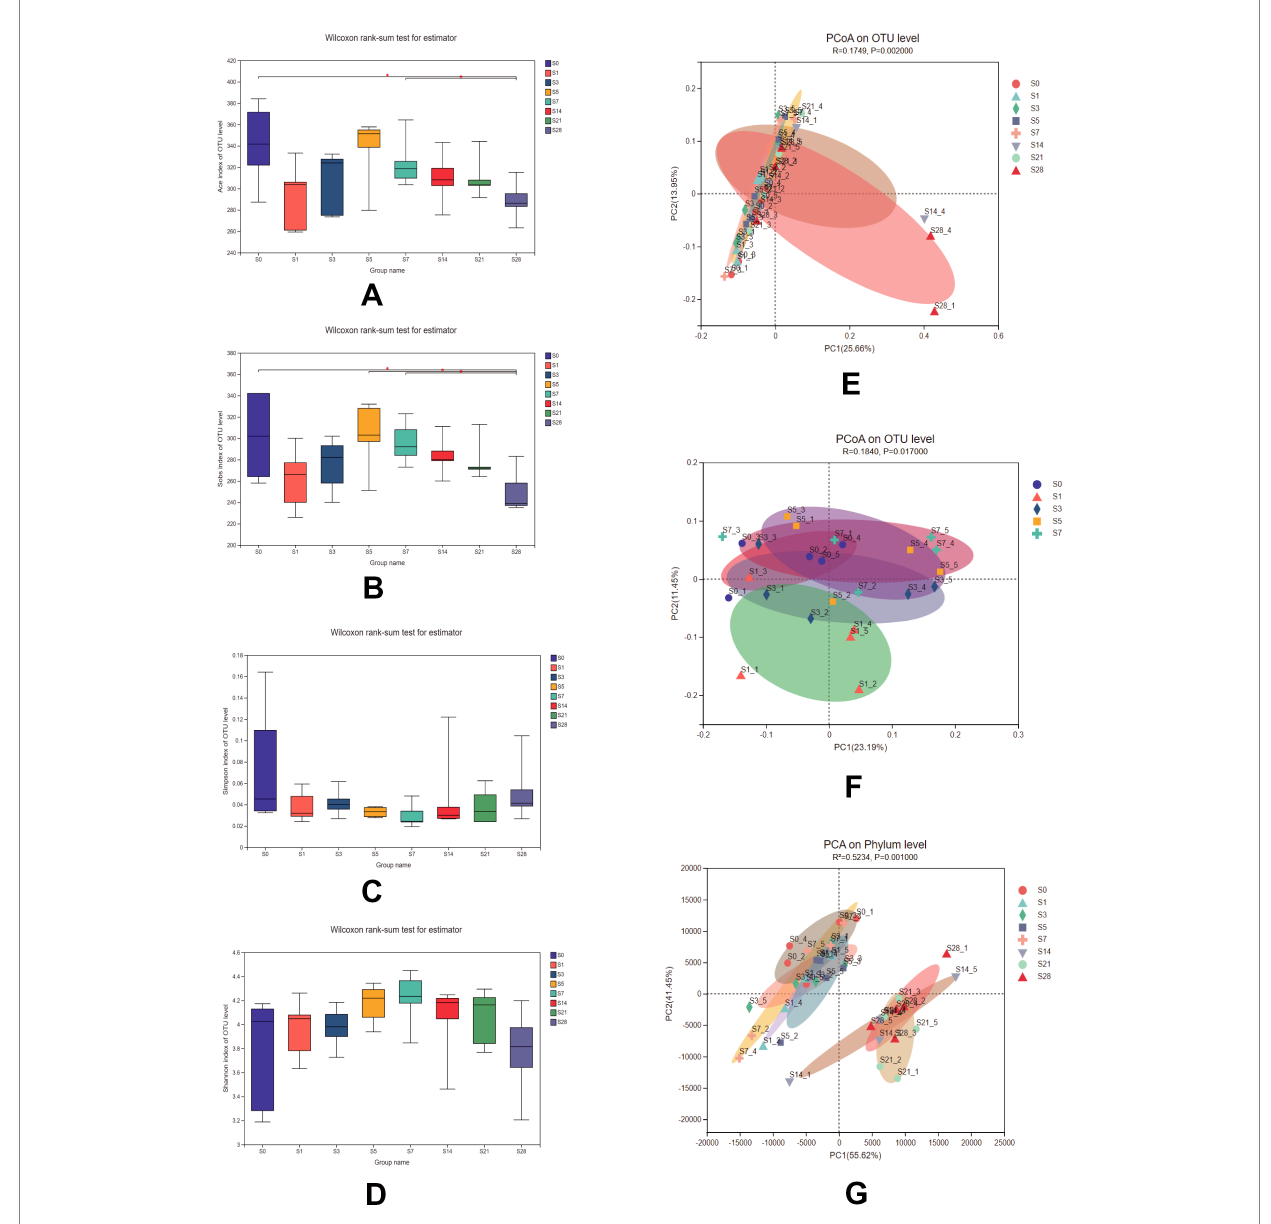
FIGURE 2 Comparison of the Ace (A) , Sobs (B) , Simpson (C), and Shannon (D) indices among the 8 groups. Data were analyzed using the Wilcoxon rank-sum test. PCoA of 8 groups (E) and within 1 week after burn (F) using unweighted_unifrac on the OTU level [ADONIS test, R = 0.1749, P = 0.002 for (E) and R = 0.1840, P = 0.017 for (F) ]. (G) PCA of samples at the phylum level using bray_curtis (ADONIS test, R 2 = 0.5234, P = 0.001). n = 5, * significantly higher ( p <